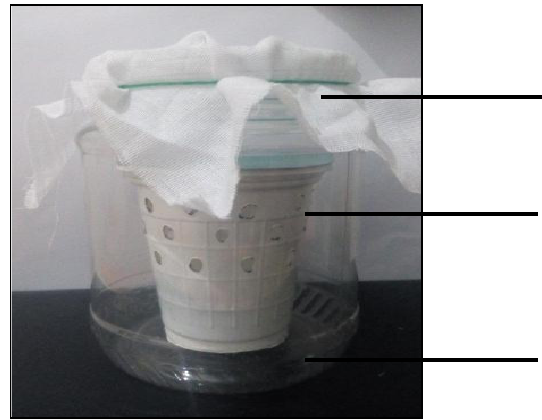
Figure 1: Contact repellency bio assay